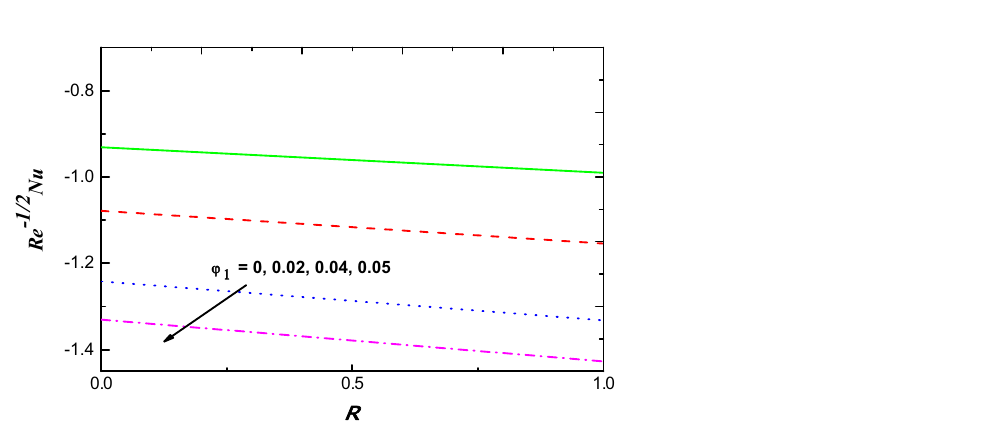
Figure 17. Re − 1 / 2 Nu Variation vs. R with ϕ 1